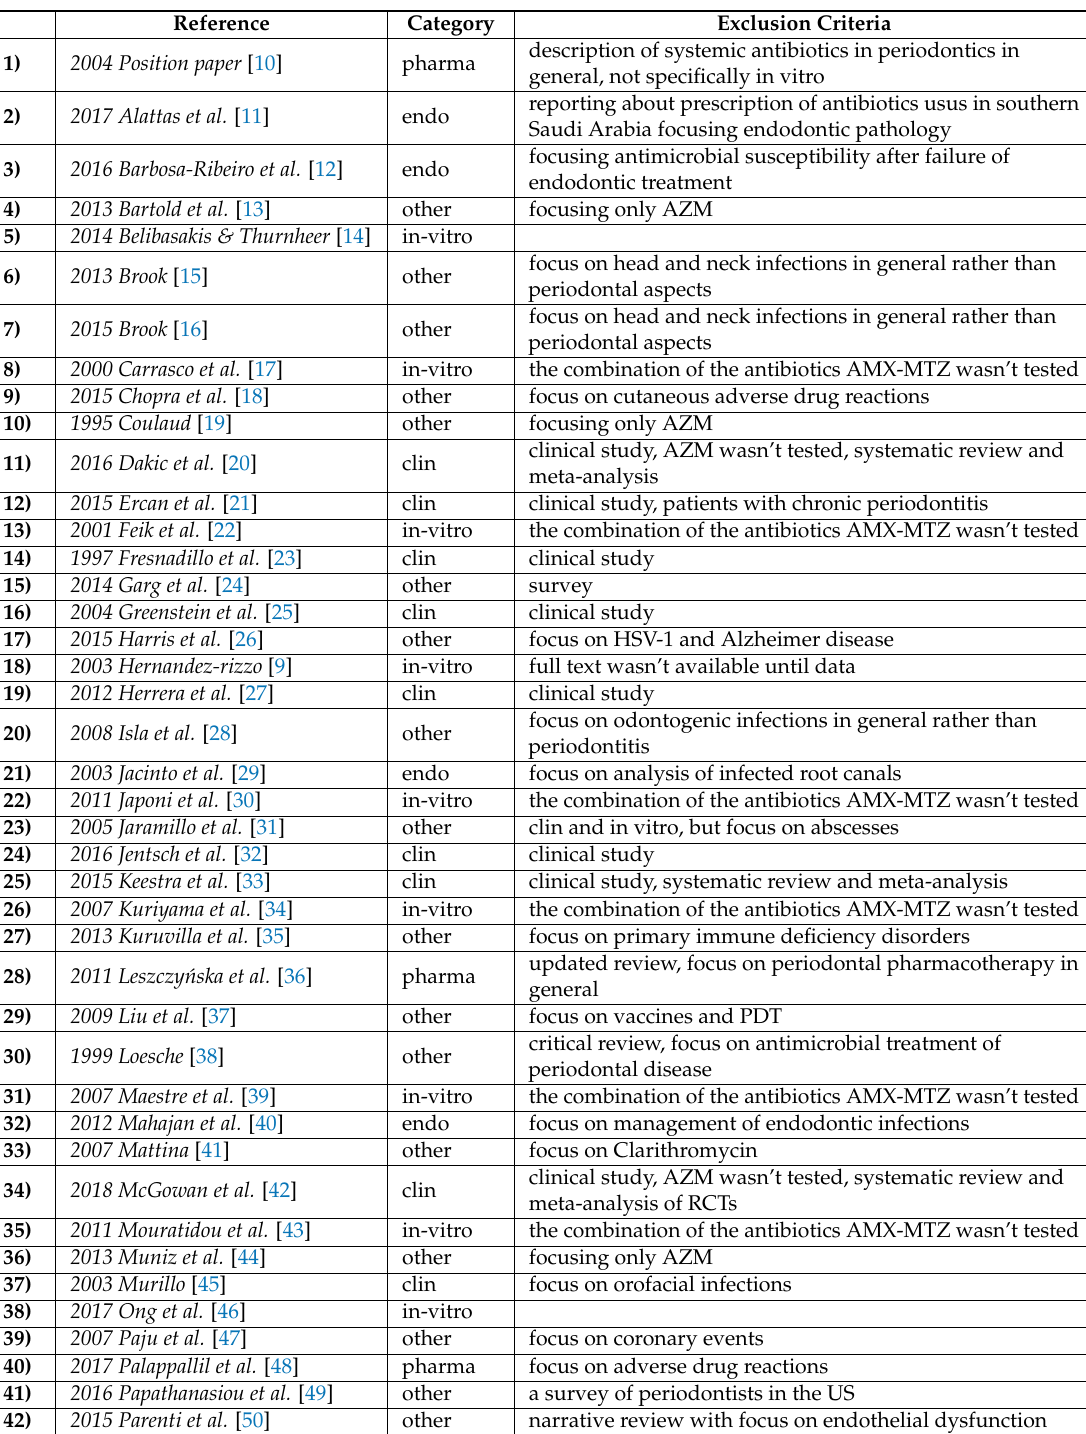
Table 1. Excluded studies. The reason for exclusion was arranged in categories pharma (for pharmacological studies), endo (for endodontic studies), other (for studies not addressing the research question), in-vitro (for in-vitro studies) or clin (for clinical